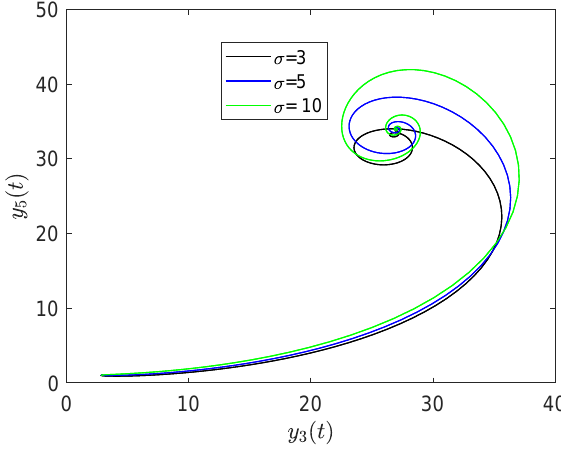
Figure 53. Phase portraits of y 3 and y 5 when varying σ .